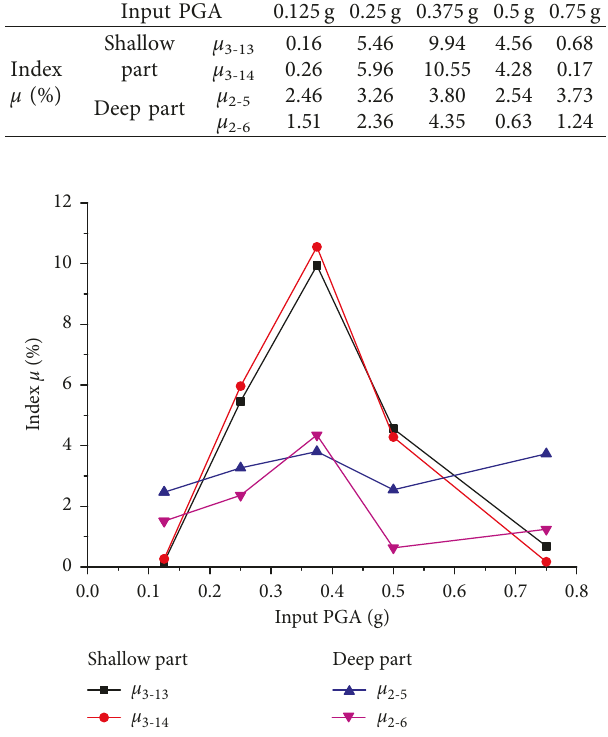
Figure 9: Relationship between index μ and input